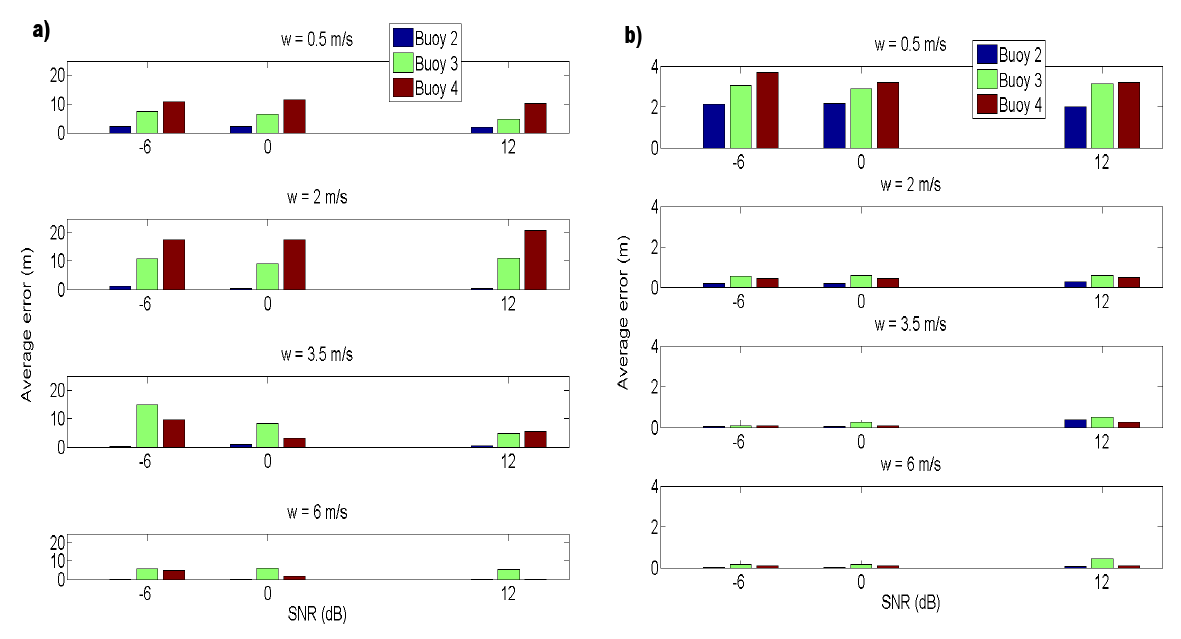
Figure 6. Average error of estimated positions for different values of SNR and wind